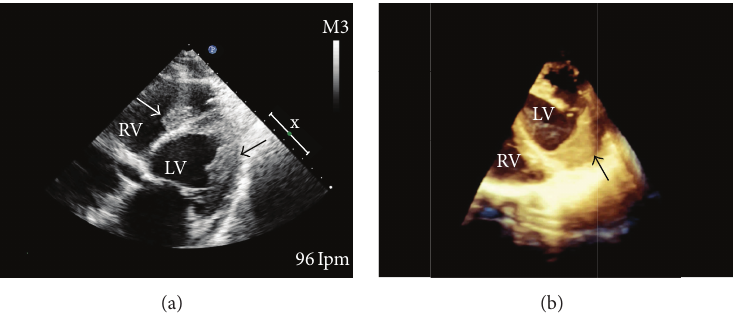
Figure 3: (a) Transthoracic echocardiogram in a modified apical four-chamber view, showing the left ventricular apex with obliteration and the lateral wall thickened by an image suggestive of a thrombus (black arrow) in the right ventricle and image suggestive of a smaller thrombus attached to the septum (white arrow). (b) Transesophageal echocardiogram with a 3D reconstruction, showing a thrombus in the left ventricle (black arrow). LV = left ventricle; RV = right ventricle.